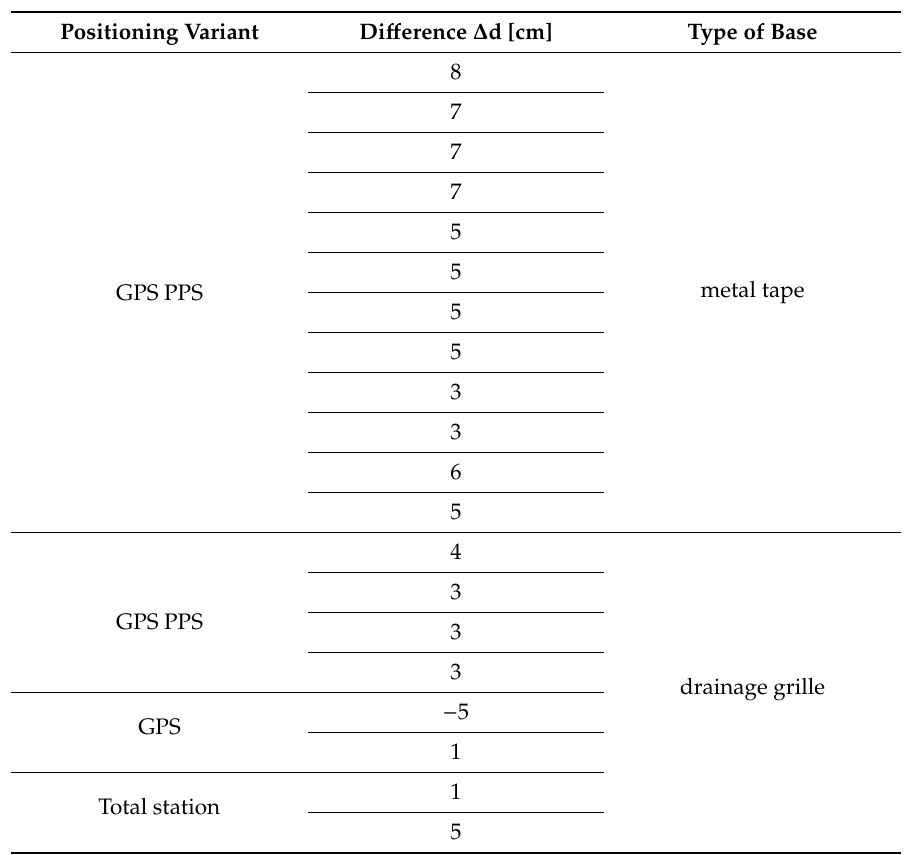
Table 1. Overview of GPR data vectorization distances in relation to the test base and drainage